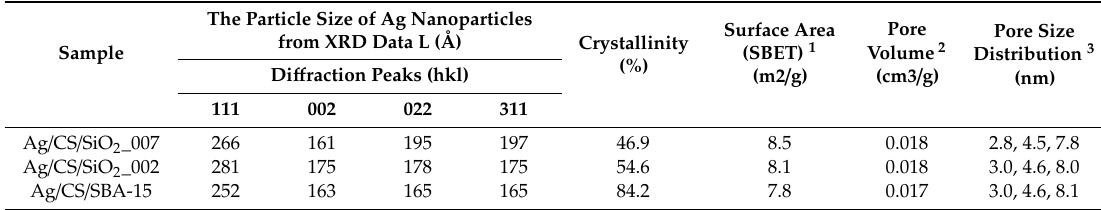
Table 1. The values of textural parameters describing the porous structure of the samples. The Particle Size of Ag Nanoparticles from XRD Data L Sample